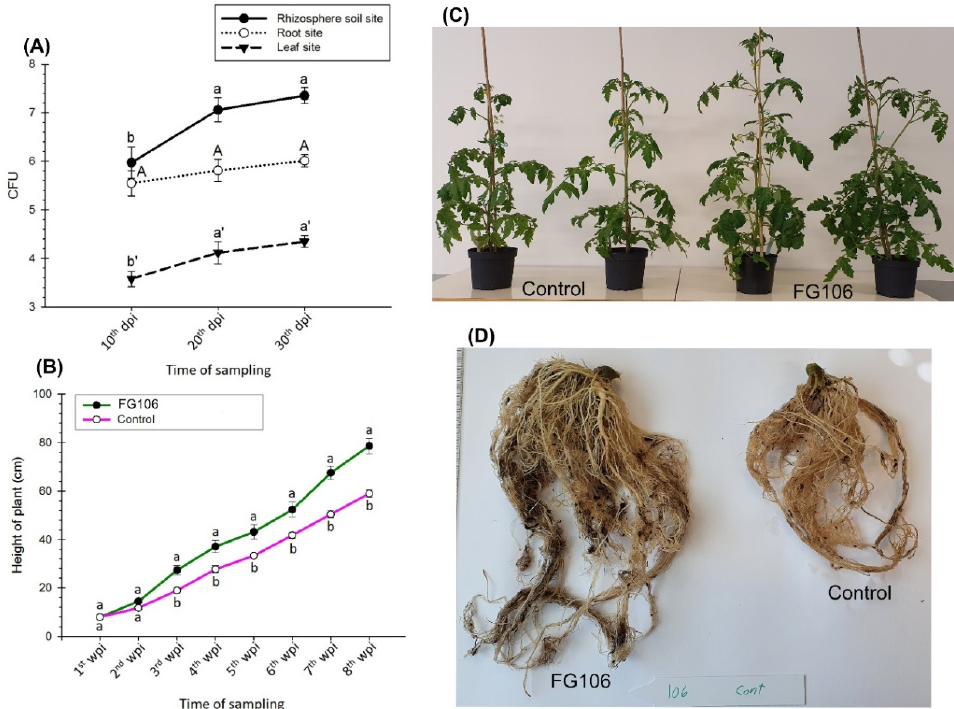
Figure 6. Colony-forming units (CFUs) of P. aeruginosa strain FG106 in the rhizosphere, roots, and leaves of tomato seedlings up to 45 days post-inoculation ( A ) and its effects on seedling height ( B ), growth of above-ground parts ( C ), and root growth ( D ). Data represent means ± SD of six replicates. Means labelled with different letters differ significantly according to Student’s t test at p < 0.01.